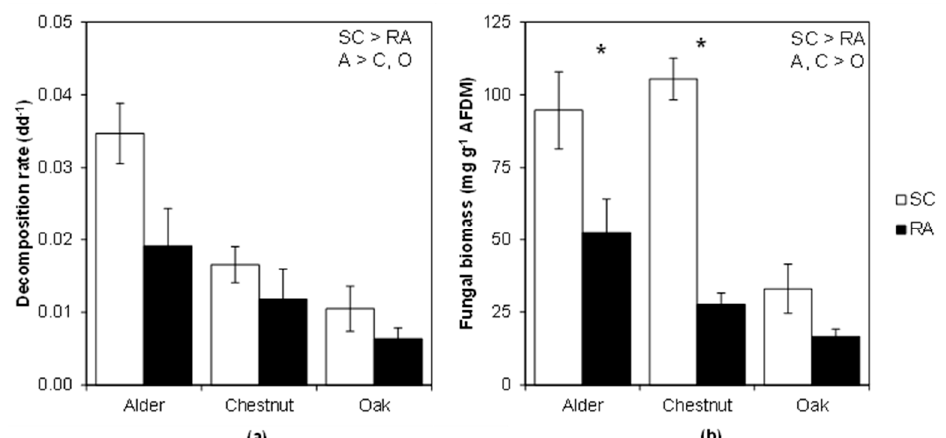
Figure 1. ( a ) Decomposition rates rates and ( b ) fungal biomass (mean ± SE) in the stream channel (SC) and riparian area (RA) for the three leaf species (Alder, A; Chestnut, C; Oak, O). Statistical differences are also shown among incubation areas and leaf species. (*) indicates differences between zones within each species (factors interaction).